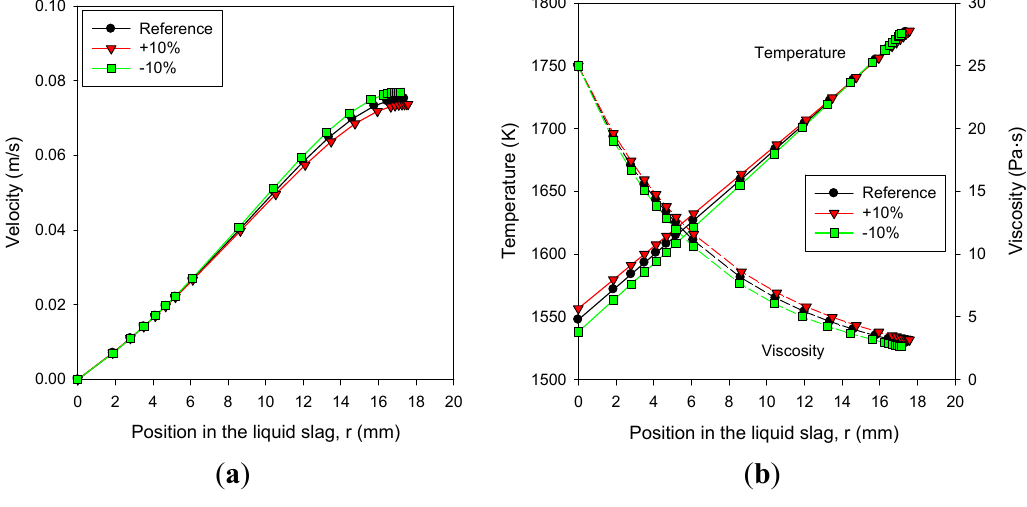
Figure 8. Effects of slag viscosity on ( a ) velocity; ( b ) temperature and viscosity distribution of liquid slag at the slag tap.